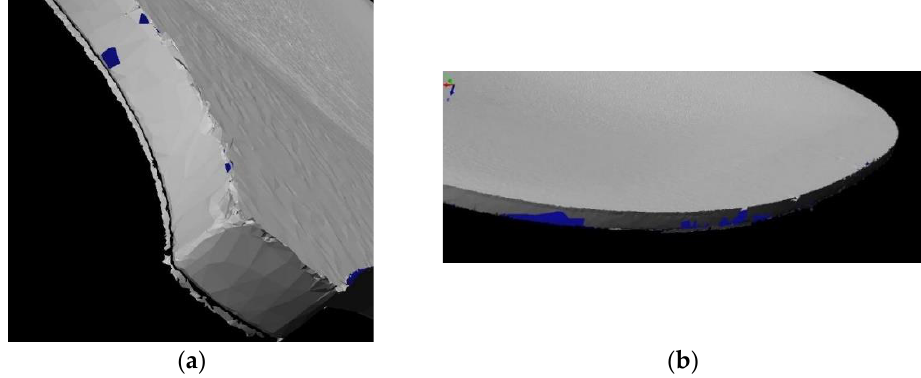
Figure 11. The initial mesh of the violin: ( a ) the misalignment of the different meshes on one side of the object; ( b ) holes on the surface.